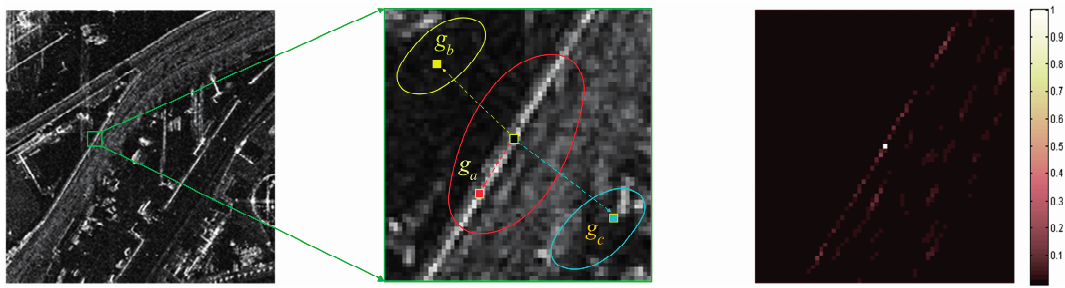
Figure 1. ( a ) SAR image; ( b ) non-stationary patch; ( c ) distribution of the